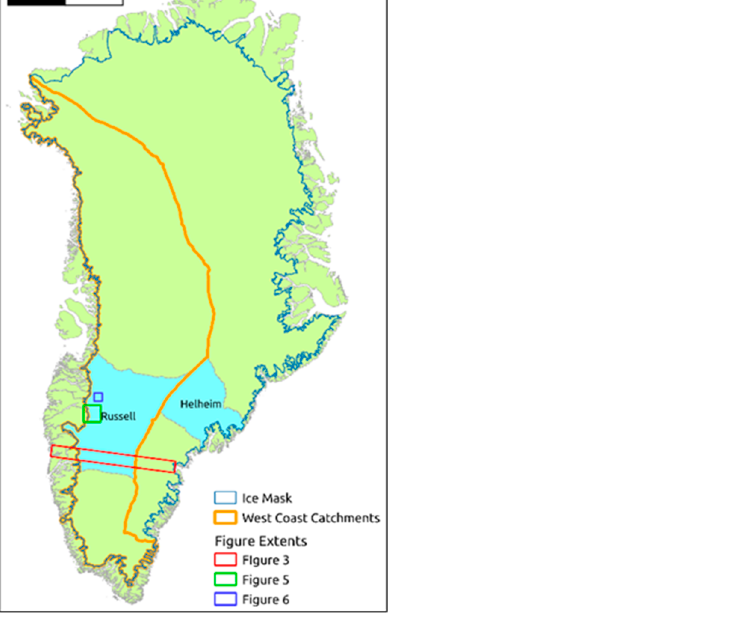
Figure 1. Study area map. This map indicates the west coast catchments used to summarize the Terra/Aqua MODIS albedo product (MCD43) data, as well as the smaller subset areas shown in Figures 3, 5, and